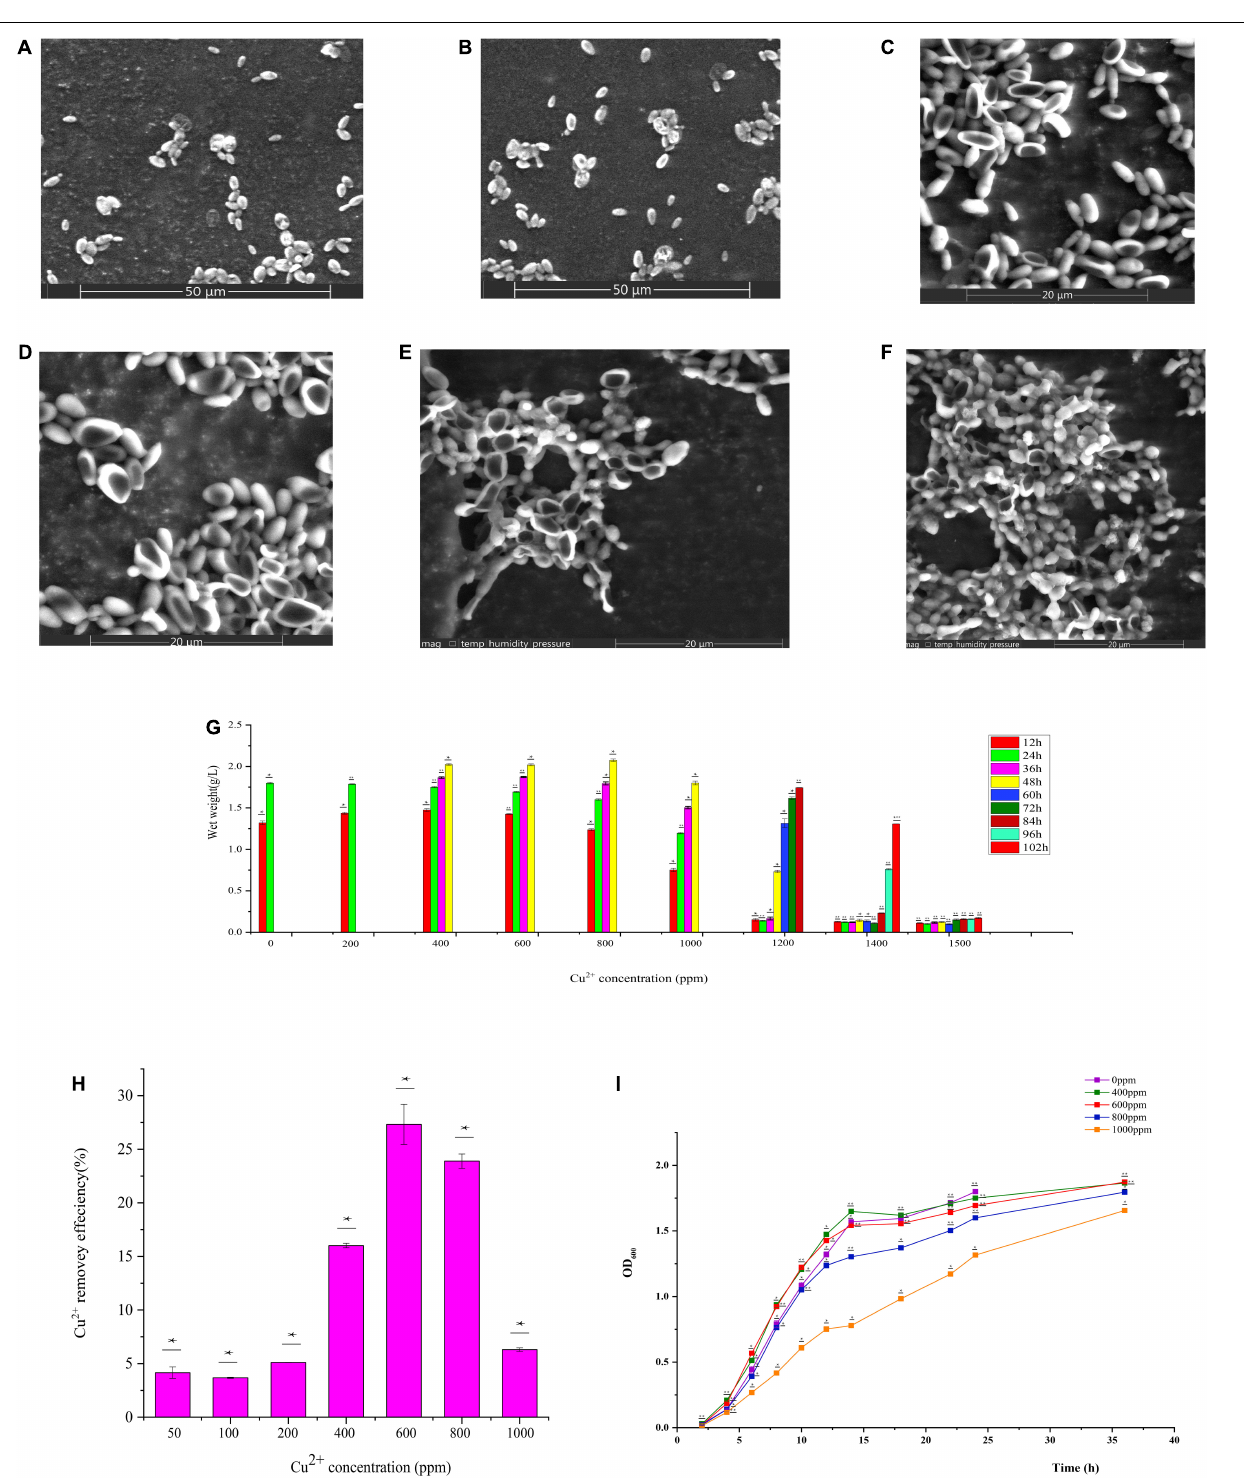
FIGURE 1 | Physicochemical properties of GXDK6 incubated for (A) 12 h under 0 ppm copper ions, (B) 24 h under 0 ppm copper ions, (C) 12 h under 600 ppm copper ions, (D) 24 h under 600 ppm copper ions, (E) 12 h under 1000 ppm copper ions, and (F) 24 h under 1000 ppm copper ions. (G) Copper ion tolerance of GXDK6. (H) Copper ion removal ability of GXDK6. (I) Growth curve of GXDK6 under inconsistent copper ion concentrations. All experiments were carried out three times, and standard deviation analysis was carried out on the data. * Means 0.01 < SD < 0.05, ** means 0.001 < SD < 0.01, and *** means SD < 0.001.